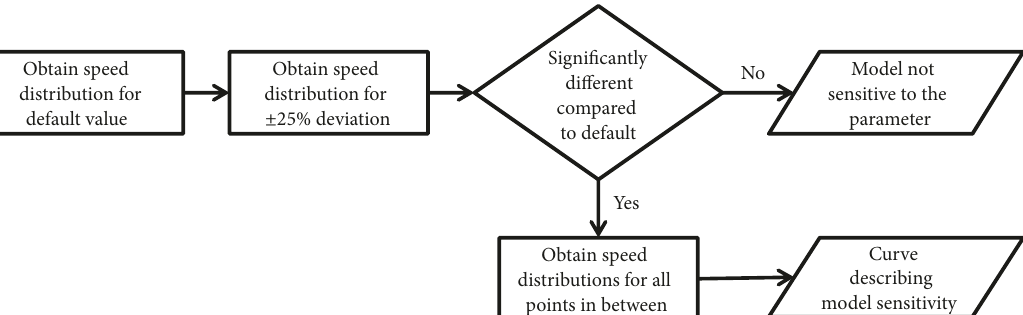
Figure 1: Overview of the sensitivity analysis methodology. The process depicted in the figure is performed for all combinations of the 7 scenarios and 7 parameters.